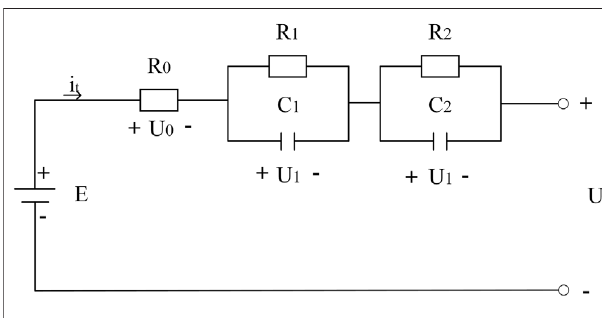
FIGURE 1 | The structure of the fractional second-order RC